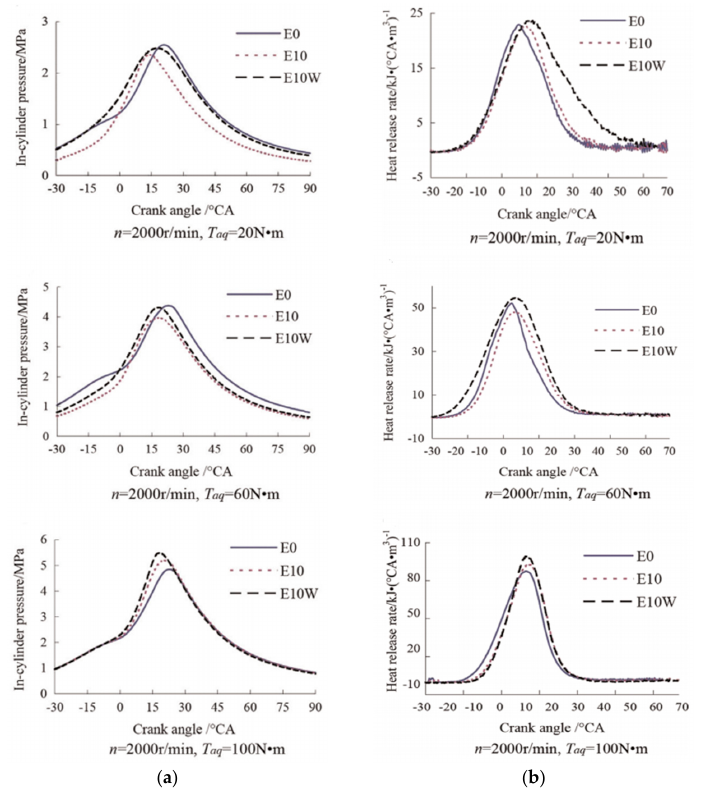
Figure 2. The variation of ( a ) in-cylinder pressure ( b ) heat release rate with crank angle for a fixed speed of 2000 rpm, and engine torque of 20 Nm, 60 Nm, and 100 Nm. (E0 = 0% ethanol & 100% gasoline, E10W = HE10 = 10% hydrous ethanol & 90% gasoline, E10 = 10% ethanol & 90% gasoline) [38]. Copyright (2015) Elsevier Ltd.